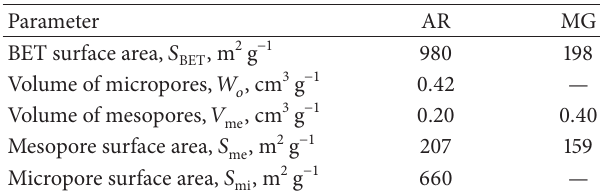
Table 1: Physicochemical properties of adsorbents used.